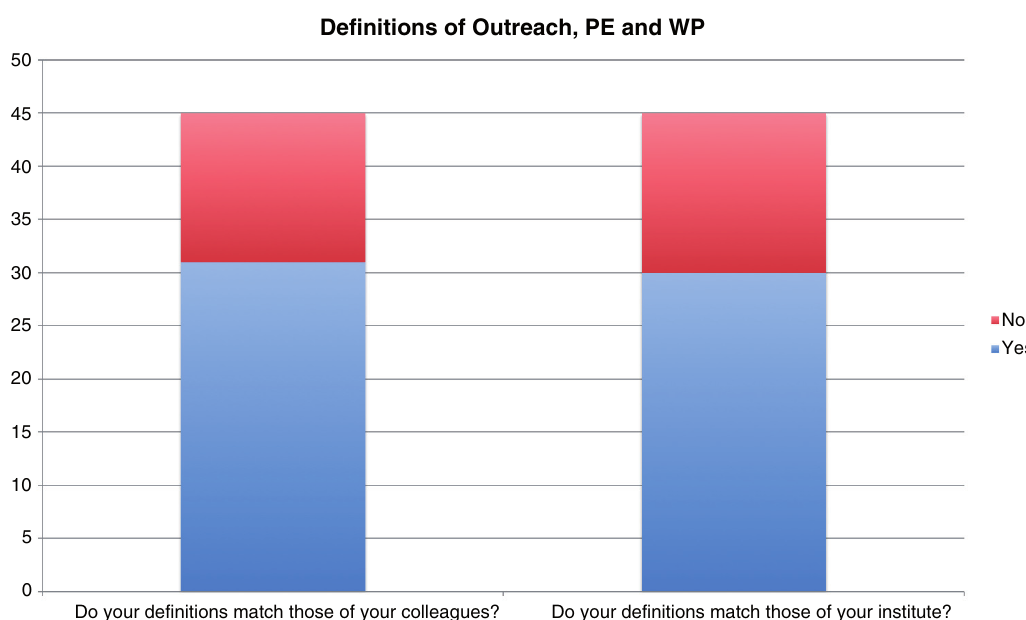
Figure 1. Stacked columns showing how participant’s personal definitions differed from those of their colleagues and institutes/ companies.